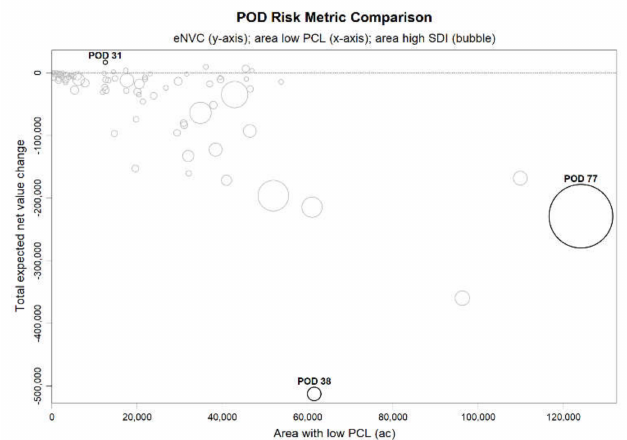
Figure 4. Bubble chart comparing the sum of expected net value change (eNVC; y -axis) to total area rated as low probability of suitable potential control location (PCL; x -axis) to total area rated as high in the suppression di ffi culty index (SDI; bubble size). Three PODs are highlighted to reflect a range of